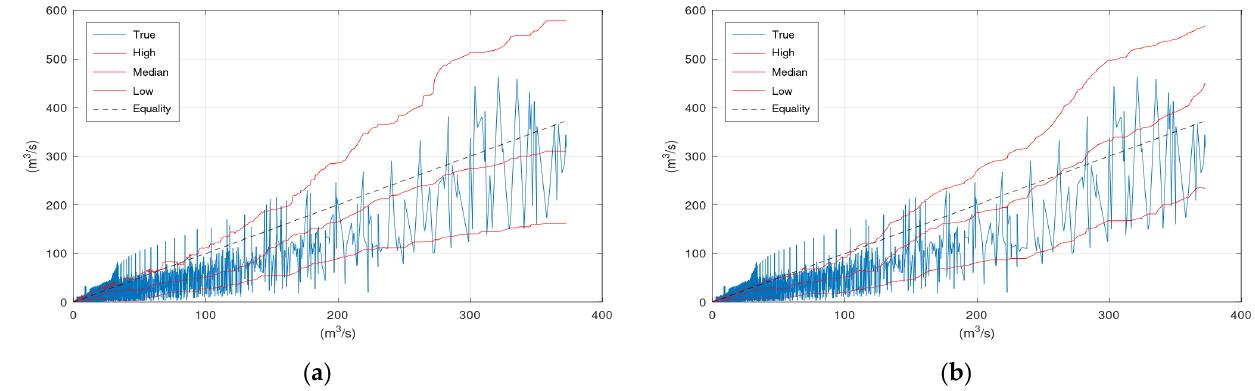
Figure 6. Scatter plot of the Sieve River case study: ( a ) KNN; ( b ) Bluecat. Figure 7 displays the CPP of the application of KNN and Bluecat to the validation period of the Sieve River case study. The CPP of KNN appears slightly closer to the Equality line.